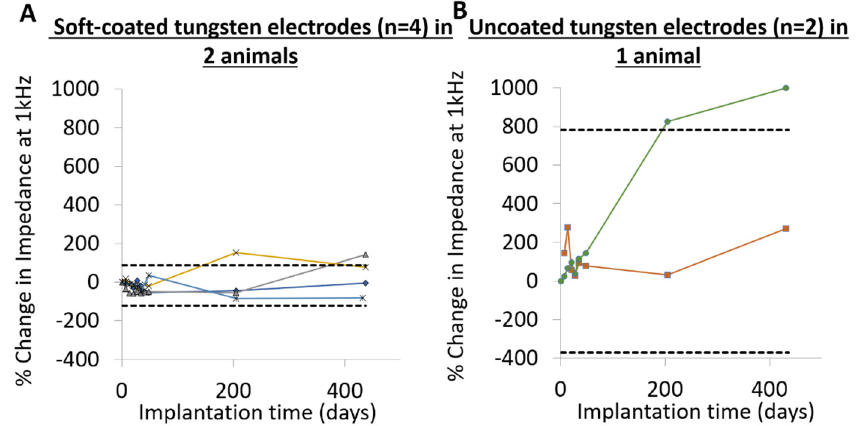
Figure 9. Comparison of change in absolute impedance at 1 kHz for ( A ) soft-coated and ( B ) uncoated tungsten probes over >432 days. Dotted lines indicate 95% confidence intervals assessed over all data points across implantation times within the group (soft-coated vs. uncoated).